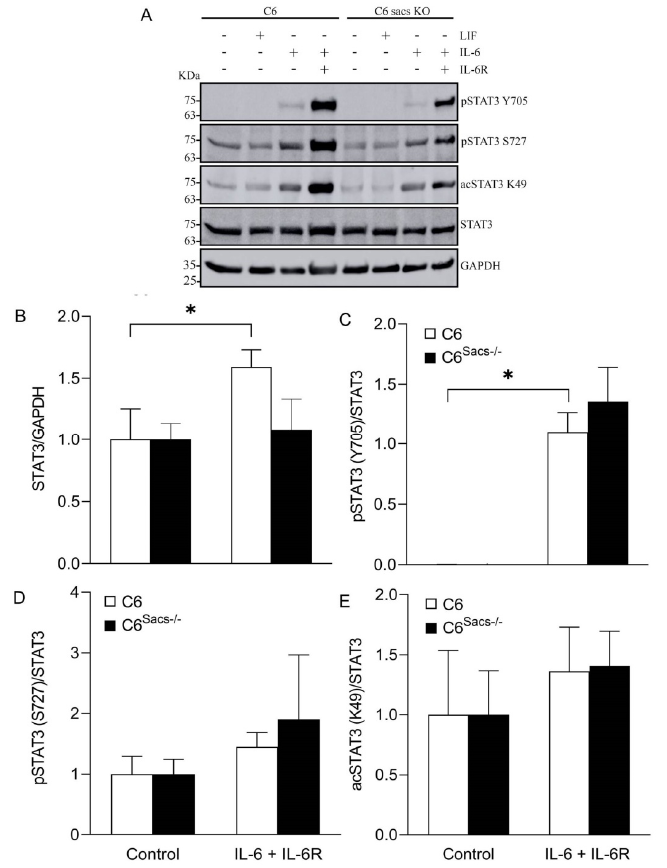
Figure 5. Sacsin deletion impairs response to inflammatory cytokines. Reference C6 and C6 Sacs − / − strains were incubated with LIF and IL ‐ 6 cytokines (200 and 30 ng/mL, respectively) for 20 min, but a strong response was only observed upon the addition of the soluble IL ‐ 6 receptor (IL ‐ 6R, 60 ng/mL) in combination with IL ‐ 6. Rate ‐ limiting, post ‐ translational modifications of STAT3 were used as surrogates of STAT3 activation, namely Y705 and S727 phosphorylation and K49 acetyla ‐ tion. ( A ) Representative Western blot images. ( B – E ) Densitometry analysis of bands from at least 3 independent experiments normalized to GAPDH or total STAT3. White bars, reference C6 cell strain; black bars, C6 Sacs − / − cells. Data were analyzed by means of two ‐ way ANOVA, followed by a Tukey post hoc test. * p < 0.05, significant vs. IL ‐ 6+IL ‐ 6R in C6 cell strain.